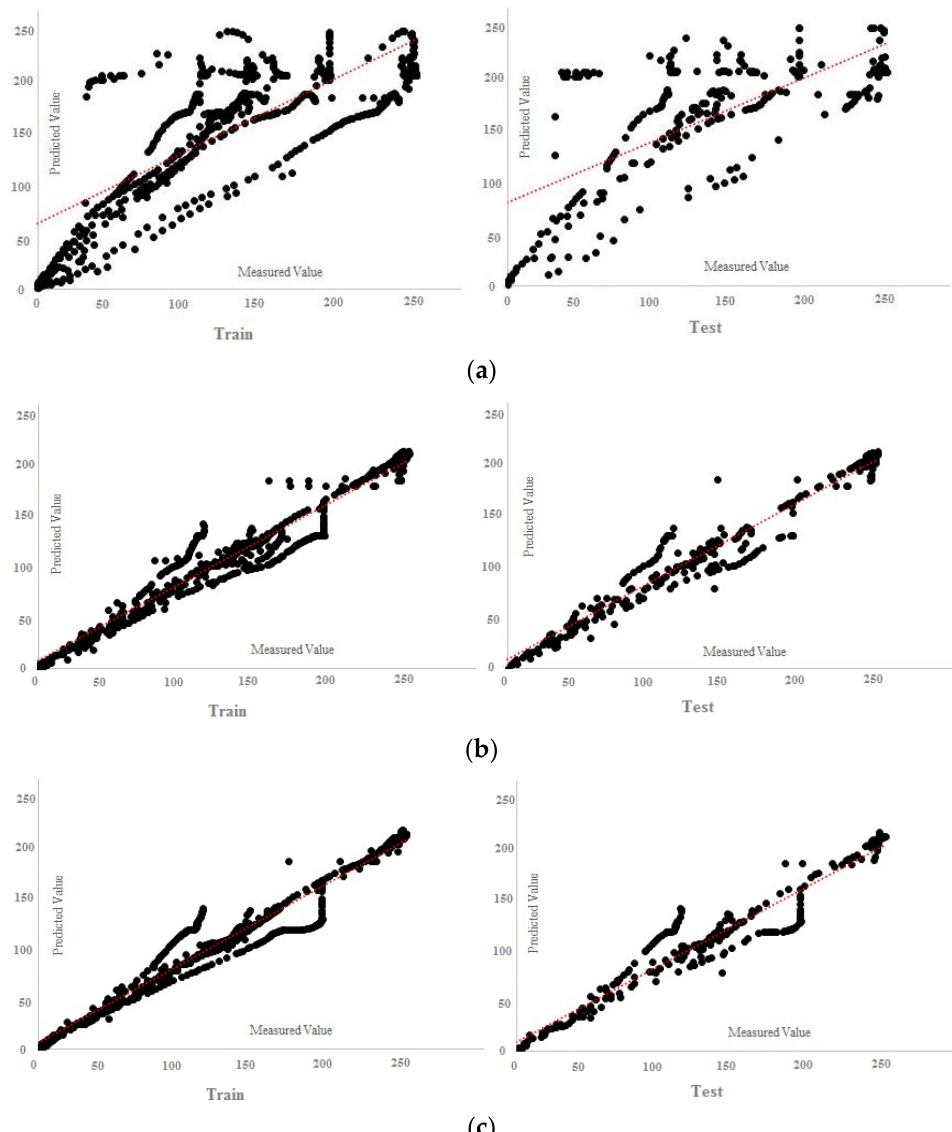
Figure 23. MPF regression charts: ( a ) one input, ( b ) two inputs, ( c ) three inputs.